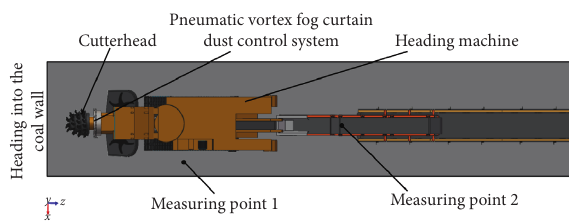
Figure 17: Experimental measurement point